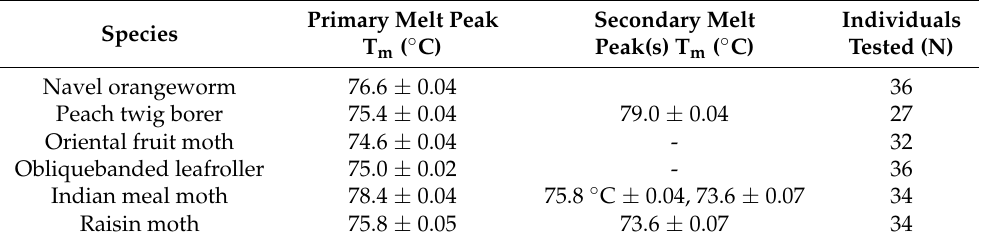
Figure 2. Melt peak chart showing the melt profile for PCR amplicons of the cytochrome oxidase subunit I gene from navel orangeworm (NOW-red), peach twig borer (PTB-green), oriental fruit moth (OFM-purple), obliquebanded leafroller (OBLR-orange), Indian meal moth (IMM-pink), and raisin moth (RM-blue); a symbol was added to the peak point of each melt curve. Only three individuals per species are included in the figure to aid readability. Table 1. Melt peak profile for examined pests including estimated melt peak temperature (T m ) for both primary and secondary peaks with 95% confidence interval.